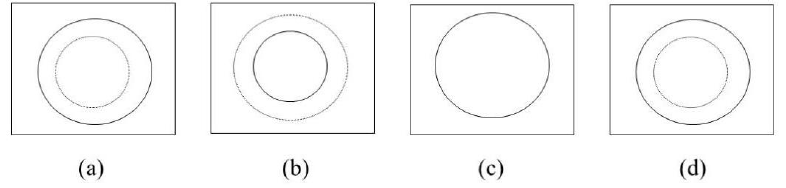
Figure 7. Demonstration of the judgment process when there is only one treetop in the fine layer.